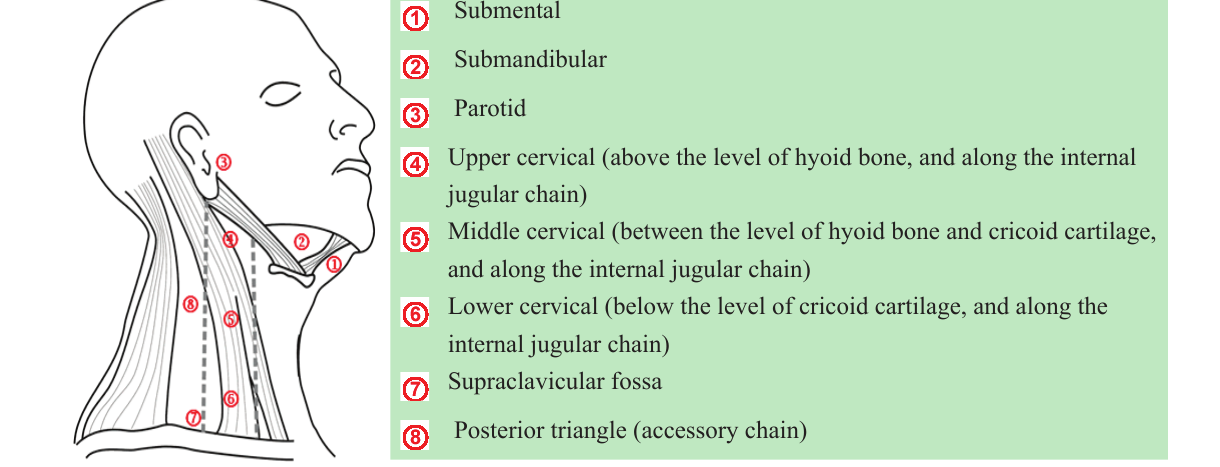
Figure.1: Ultrasound classification of cervical lymph